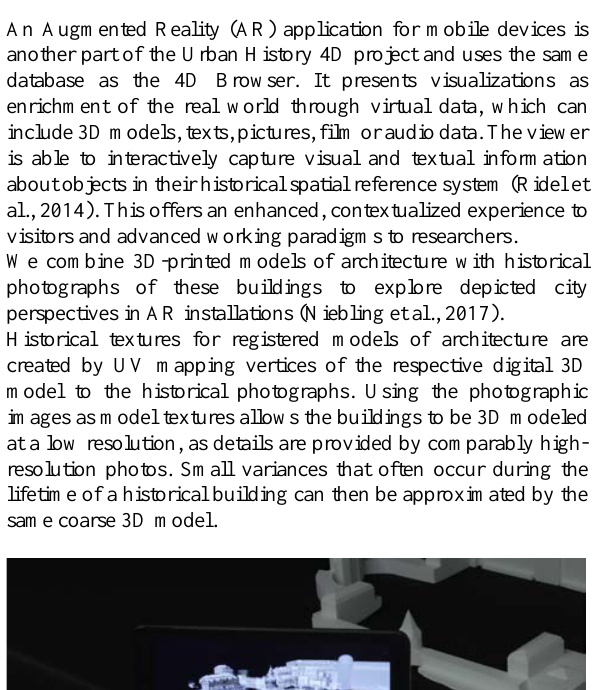
Figure 12. 3D model of the ruined Sophienkirche: abstract reconstruction, reduced to footprint as transparent visualization (top left) (not displayed: solid footprint model); geometric reconstruction, showing remaining parts without (top right) and with (bottom left) textures of historical photographs; transparent visualization of the shape of the church before its destruction (bottom